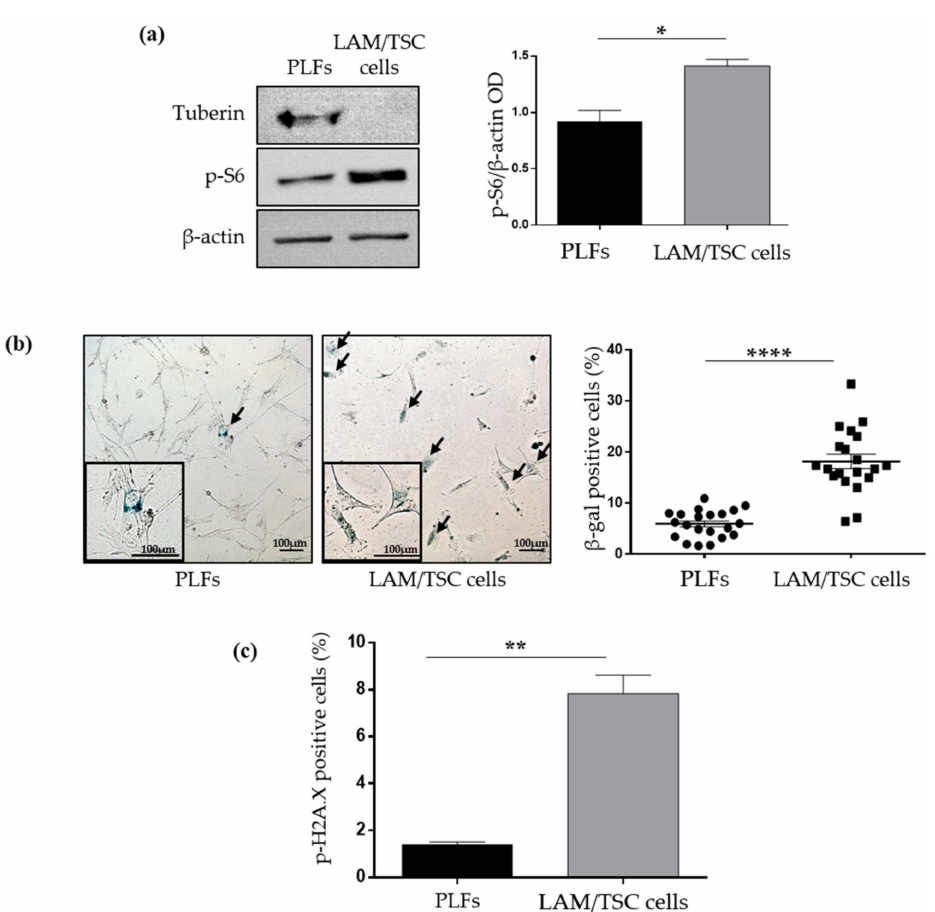
Figure 1. Analysis of senescent features in PLFs and LAM/TSC cells. ( a ) Left panel: expression of tuberin and levels of phosphor-S6, mTOR substrate, were analysed by western blot in PLFs and LAM/TSC cells. B-actin was used as loading control. Representative images are shown. Right panel: densitometric analysis of p-S6/ β -actin. Results are shown as mean ± SEM ( n = 4). Student’s t -Test, * p < 0.05. ( b ) Representative images of SA- β -Galactosidase staining of PLFs ( left ) and LAM/TSC cells ( right ) are shown. Senescent cells (blue cells) are highlighted by arrows. Higher magnifications of senescent cells are shown in black squares. Scale bar: 100 µ m. The dot plot represents the percentage of SA β -galactosidase positive cells obtained by counting the positive cells on the total number of cells in 7 images of 3 independent experiments. Results are shown as mean ± SEM ( n = 21). Student’s t -Test, **** p < 0.0001. ( c ) Histograms display the percentage of PLFs and LAM/TSC cells positive to phospho-histone H2A.X (p-H2A.X) evaluated by flow cytometry analysis. Results are shown